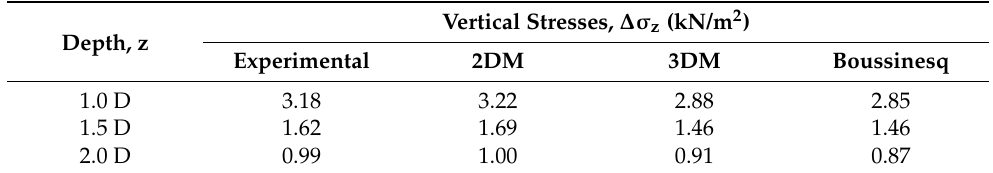
Table 4. Vertical stress values beneath the centerline of the 150 mm circular footing.